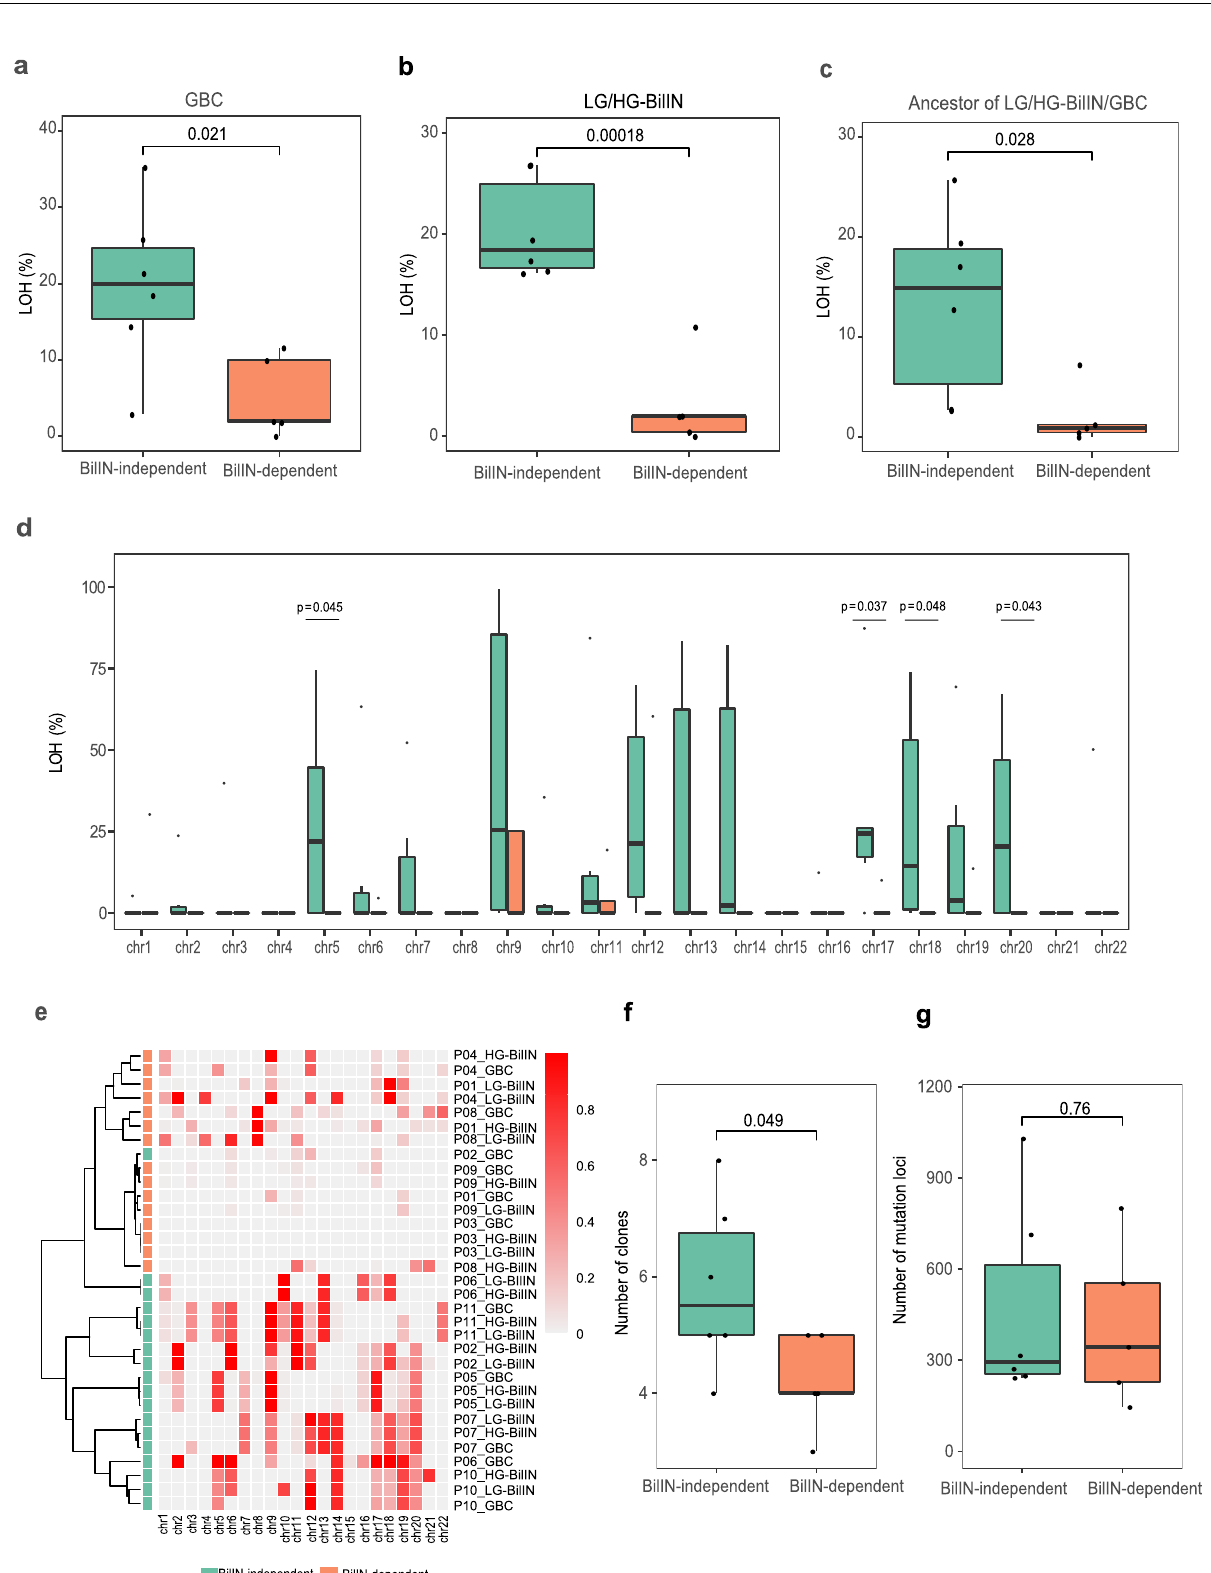
into the clonal evolution, we estimated the purity and ploidy of GBC/LG-BilIN/HG-BilIN samples using FACETS 33 and then inferred the number of clones for tumor evolution in each patient using PyClone 34 . We found that tumors in the BilIN-independent group contained signi fi cantly more clones than those in the BilIN- dependent group ( t -test, p = 0.049, Fig. 4f), although they did not